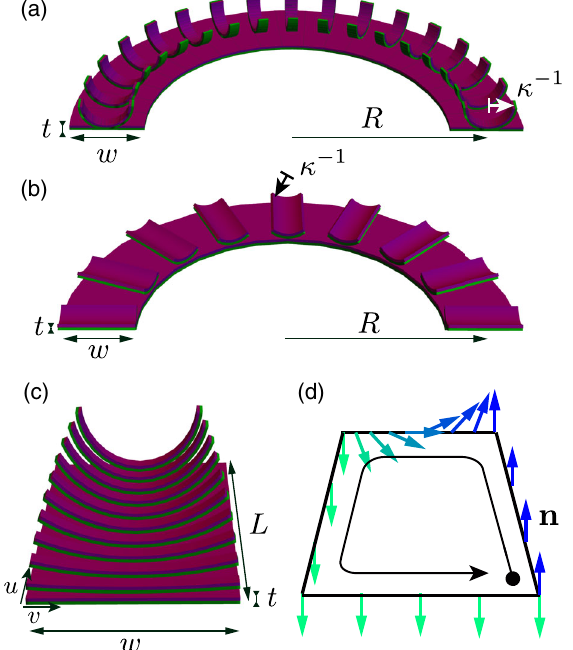
FIG. 1. Configurations of MCP-frustrated ribbons. (a) Curved ribbon with constant radial reference curvature κ . (b) Curved ribbon with constant azimuthal reference curvature κ . (c) Straight ribbon with linearly varying transverse reference curvature along the longitudinal direction (ranging from 0 to π =w ). (d) Illustration of MCP frustration via the nonconservation of the normal for the example (c). The normal evolution along the ribbon ’ s boundary in coordinate space results in no rotation along the long direction, since there is no reference curvature in this direction. At one end of the ribbon, it rotates by π along the width, whereas it does not rotate at the other end. Therefore, after integrating the normal evolution over this closed path, we obtain a nonzero rotation of the normal, contradicting the MCP equations, thus leading to an incompatible reference